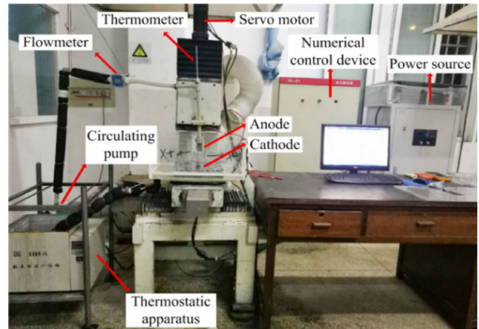
Figure 1. Experimental device of numerical control jet